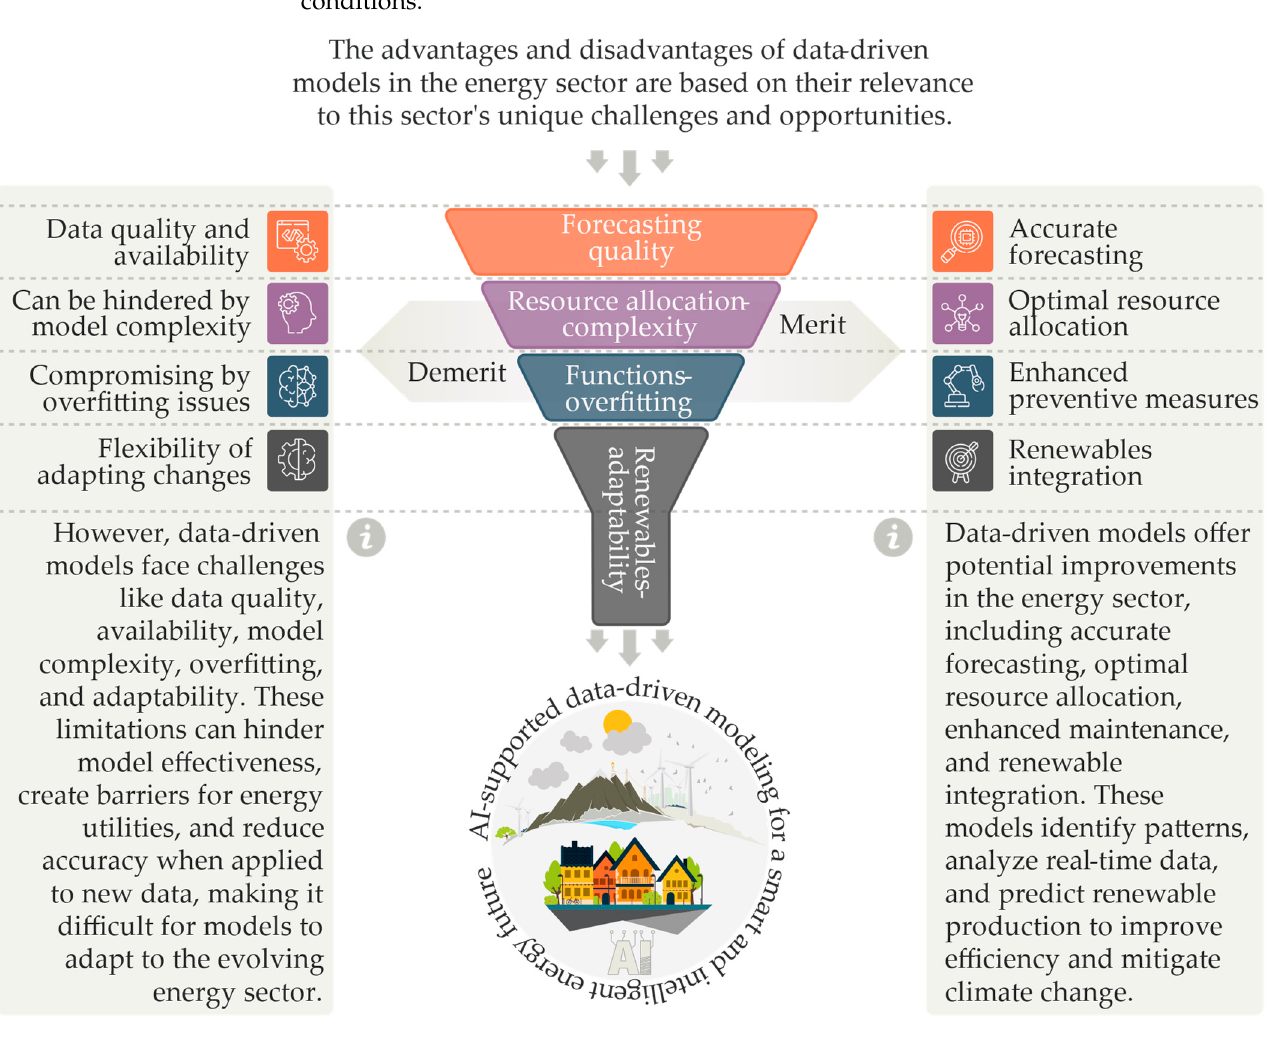
Figure 2. A visual representation of the advantages and disadvantages of data-driven models in the energy sector shows the balance between the potential improvements and the challenges these models face in addressing the sector’s unique requirements and demands.